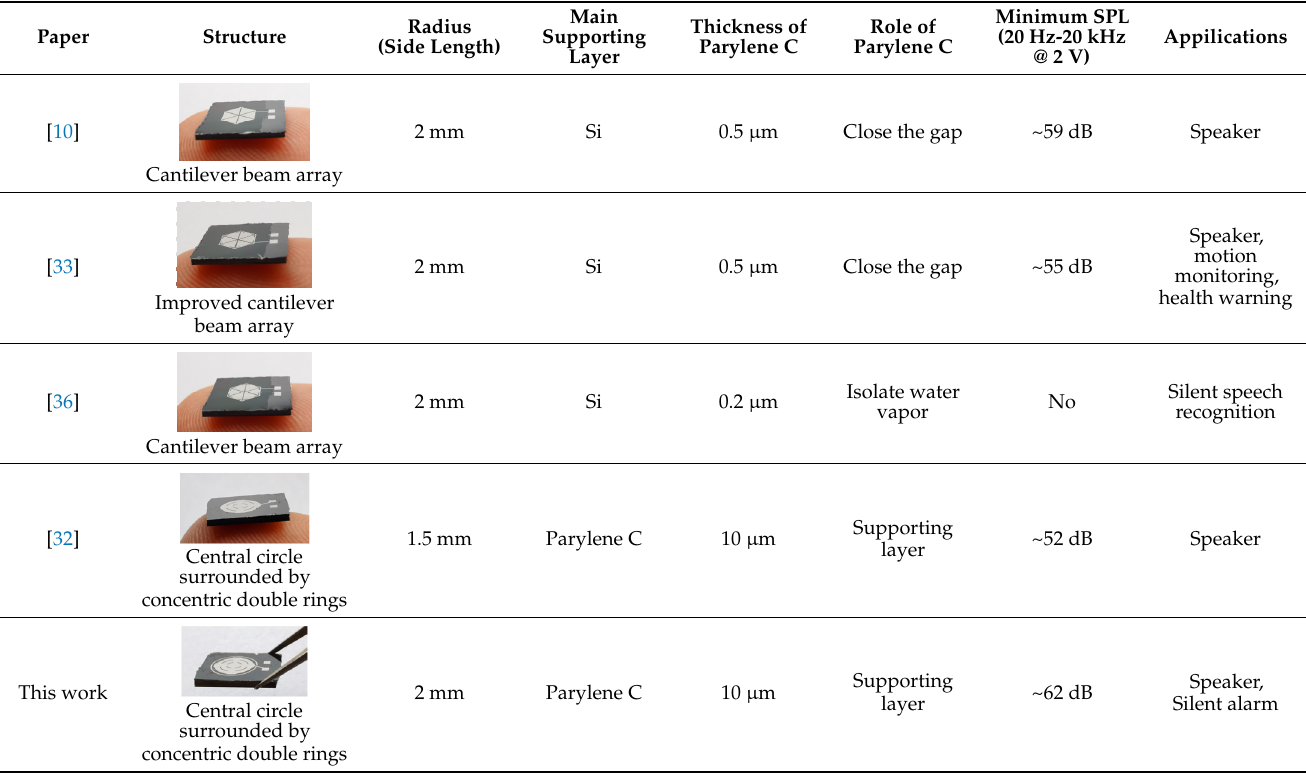
Table 1. Comparison between this work and our previous work.